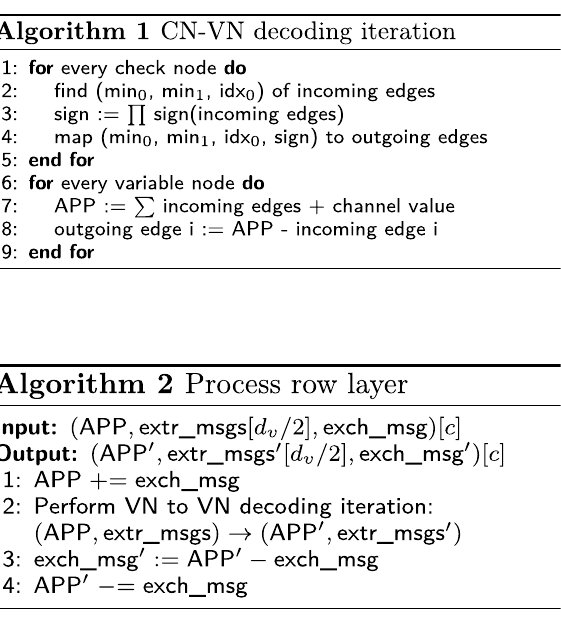
Algorithm 2 and Algorithm 3 summarize the resulting processing algorithms for a row and a column